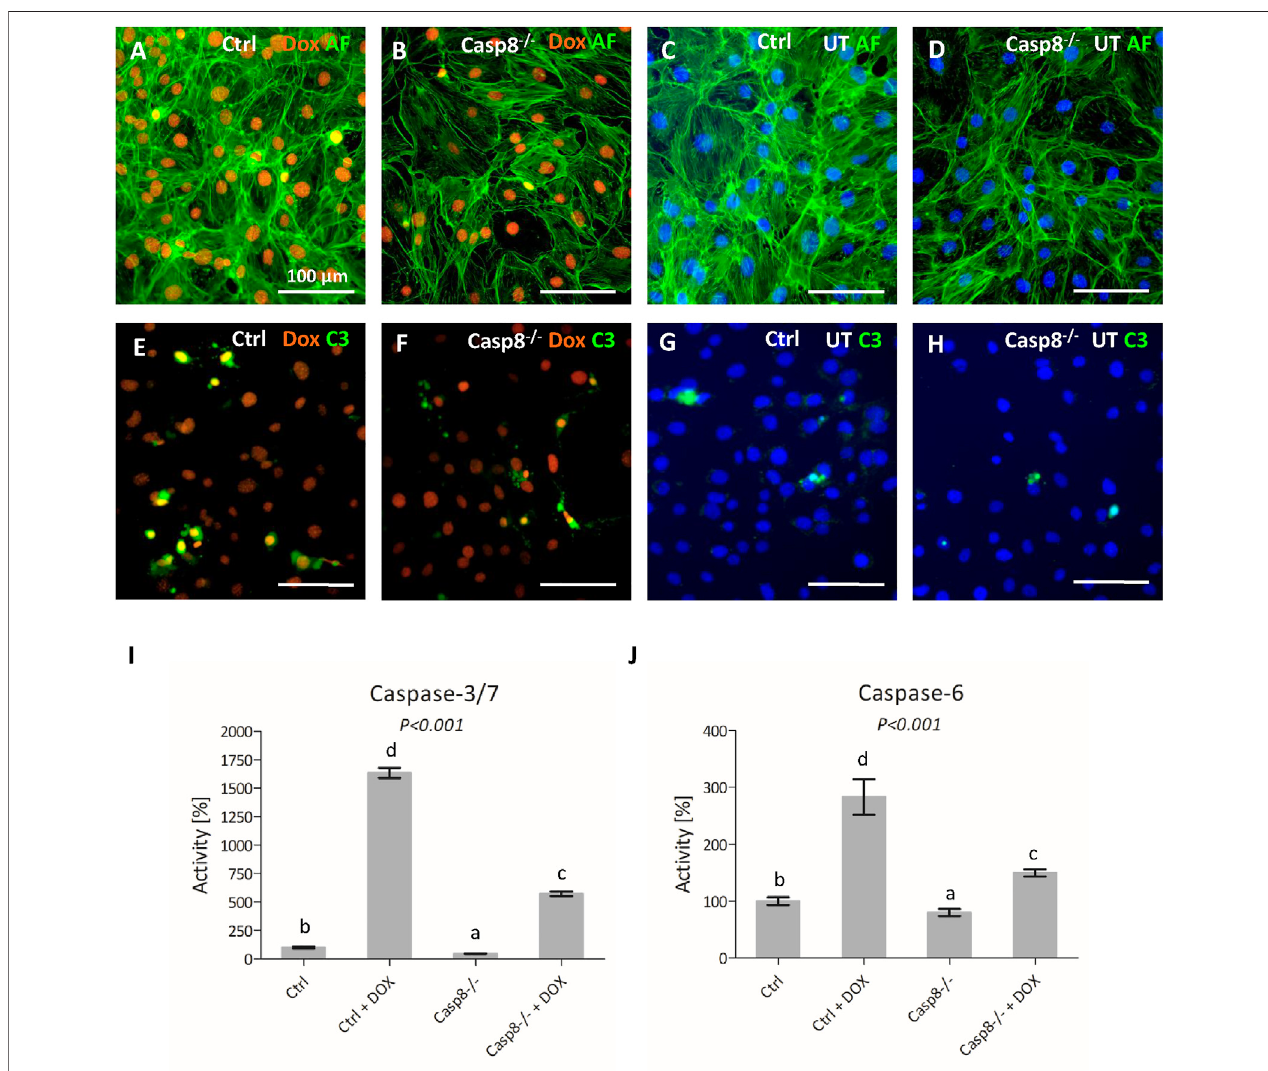
FIGURE 3 | Staining of actin fi laments (green) of control and Casp8 − / − cells after doxorubicin treatment compared to untreated controls (A – D) . Activation of caspase-3 (green) in control and Casp8 − / − cells after doxorubicin treatment compared to untreated controls (E – H) . Nuclei of doxorubicin treated samples are red, untreated samples are counterstained by DAPI (blue). Scale bar = 100 µm. Bioluminescent measurement of caspase3/7 (I) and caspase-6 (J) activity in Casp8 − / − and controlcells after doxorubicin treatment compared tountreated controls. Differentletters indicate statistically signi fi cantdifferences( p < 0.001), asestimated using ANOVA. Dox doxorubicin, UT